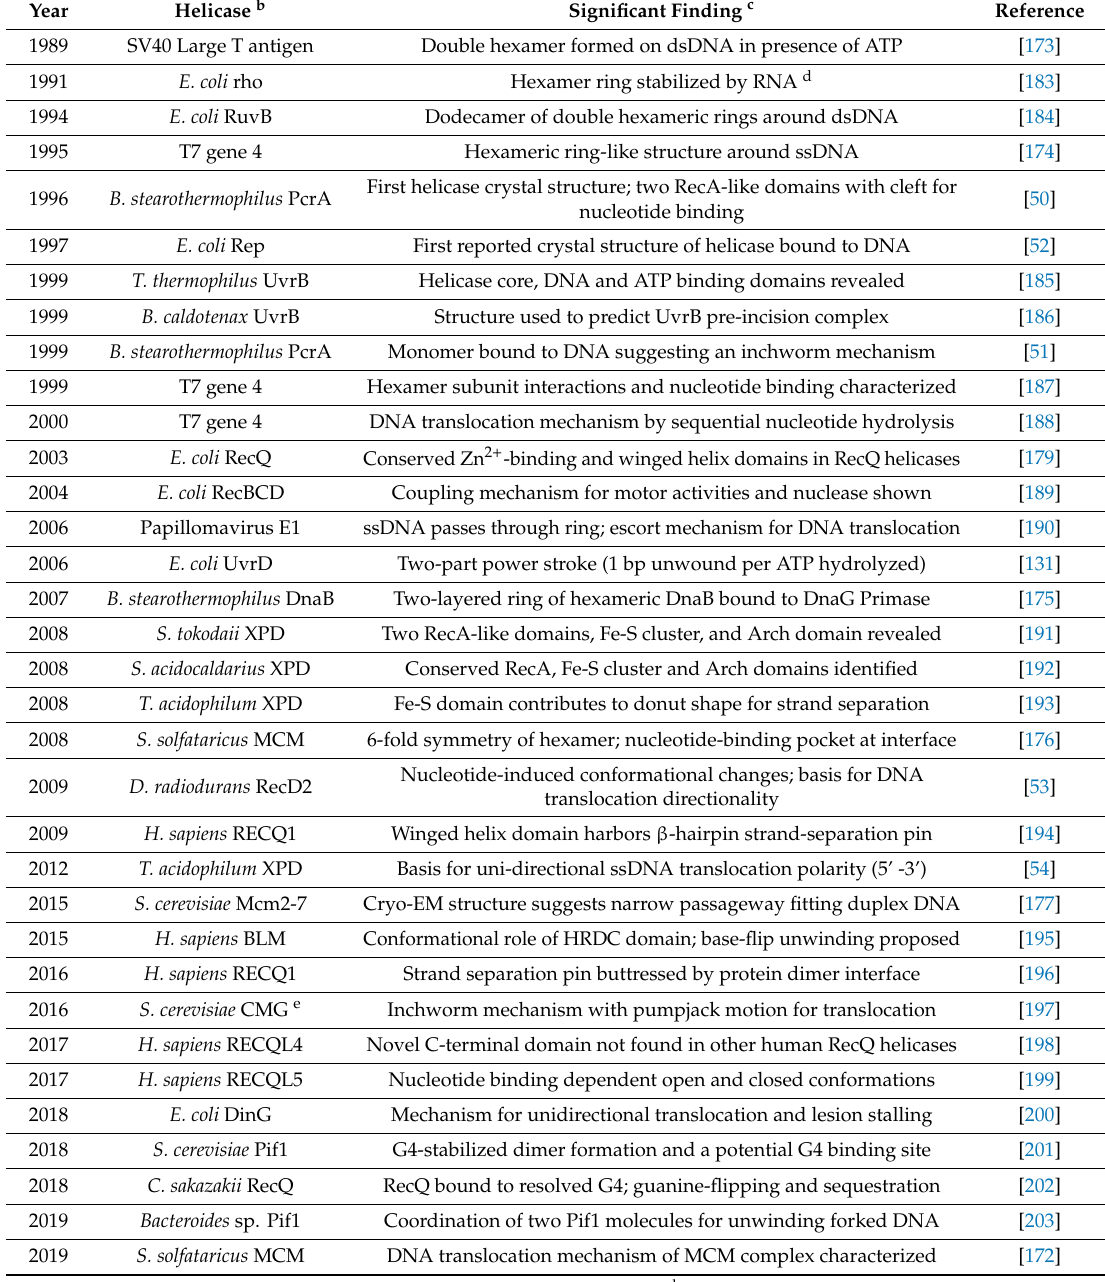
Table 2. Selected Prominent DNA Helicase Structures a